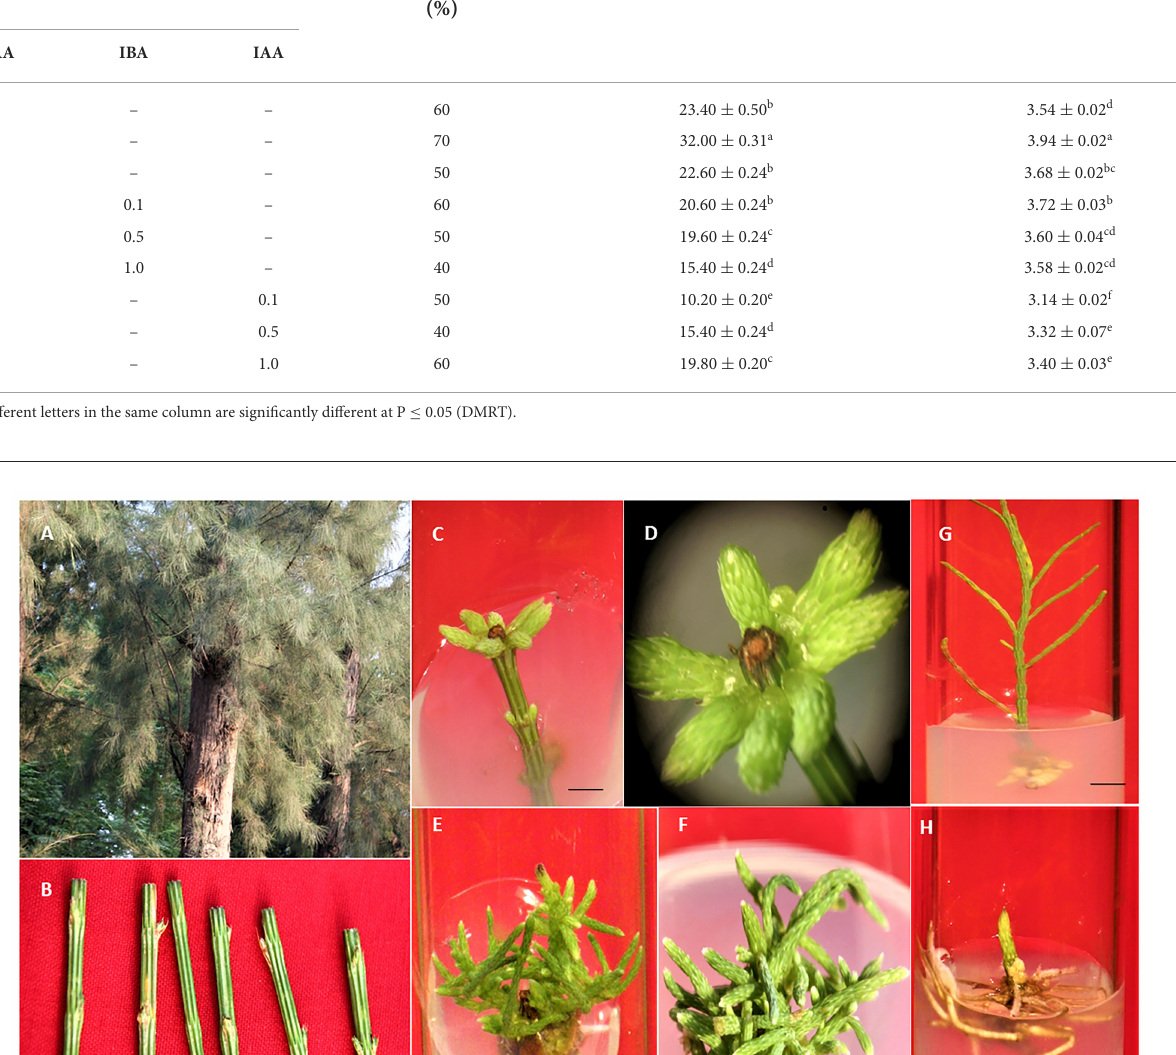
vermicompost and soilrite, 80.4% and 70.5% of plant survival were recorded, respectively (Figure 2C). Furthermore, 84.6% of survival was recorded when transferred from a controlled or culture room environment to field conditions. In vitro -derived plants grew well and showed no variation in morphological character as compared to the mother plant (Figure